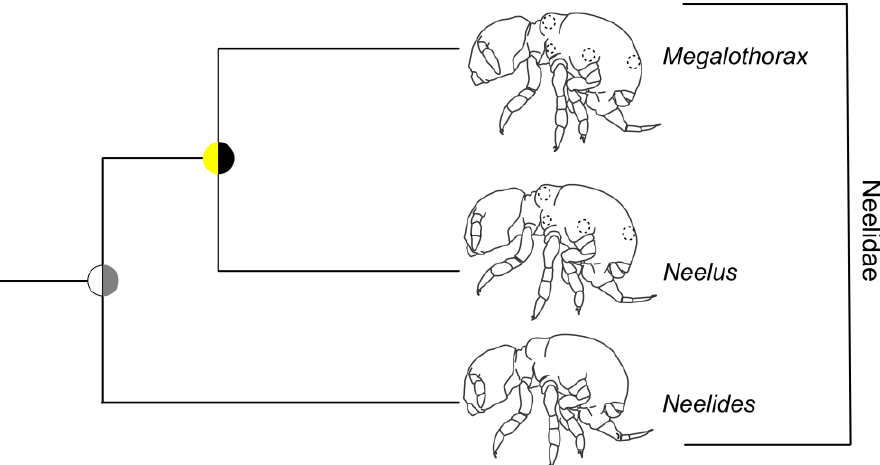
Figure 6. Summarized phylogenetic relationships of the Neelipleona genera obtained by the ML_1, ML_2, ML_3, ML_4, BI, and MP trees. Node circles represent SH-aLRT support (left side) and bootstrap values (right side), respectively, for ML_1 tree. Colors represent the following scores: black = 100; yellow = 95 – 99.9; grey = 90 – 94.9; white < 90.